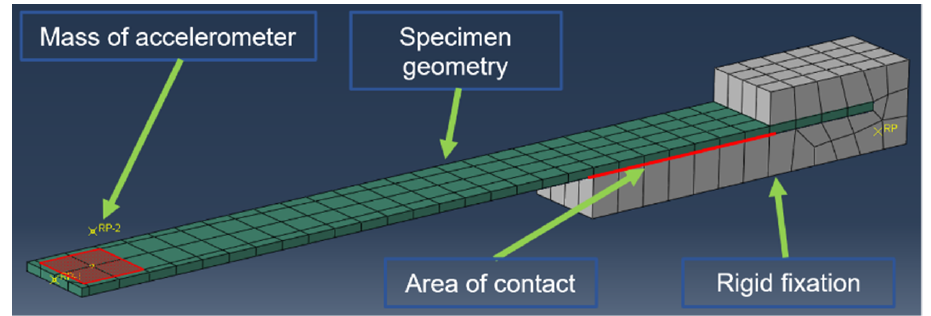
Figure 2. View of the discrete model for numerical testing.